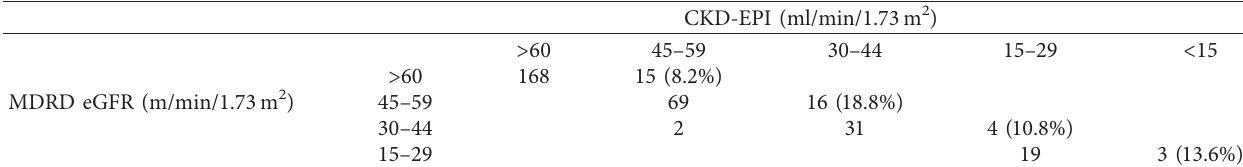
Table 4: Comparison between the MDRD and CKD-EPI